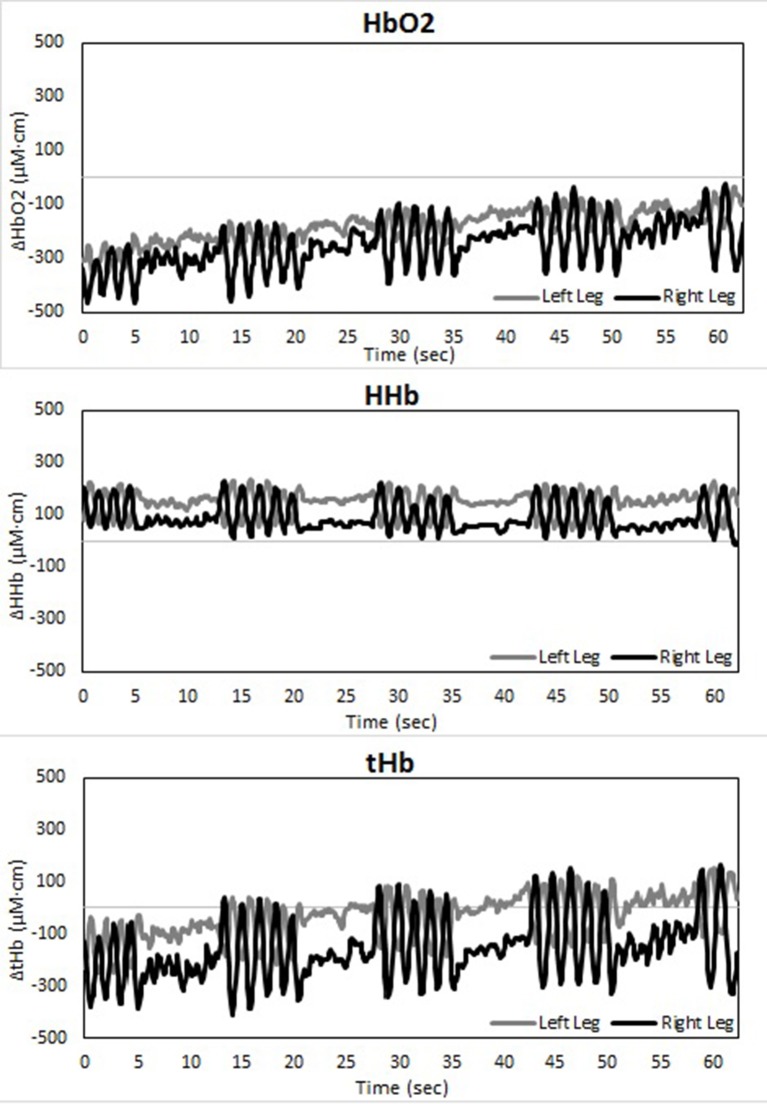
Temporal changes in right and left vastus lateralis during the long-track time trial: HbO2 (upper panel), HHb (middle panel), and tHb (lower panel).